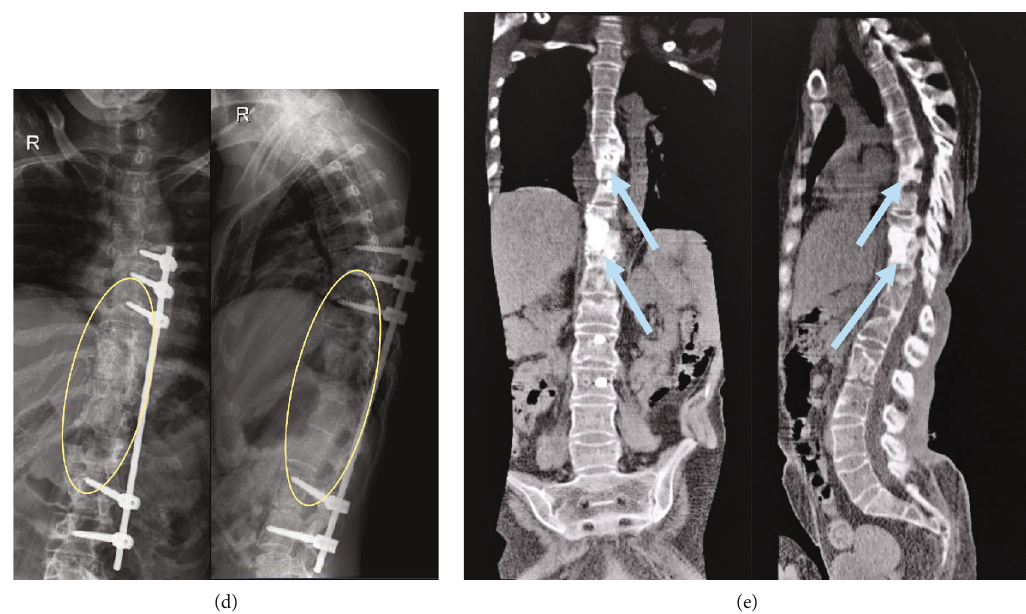
Figure 6: A 30-year-old female (case 3). (a) Preoperative radiography showed defects on multiple corpus vertebrae (T9-12). (b) One-month postoperative radiography showed around 50% of new bone formation along T9-L1, and postoperative radiography also showed instrumentation planted on the left side. (c) Three-month postoperative radiography showed around 65% of new bone formation. (d) Six- month postoperative radiography showed around 85% of new bone formation. (e) Six-month postoperative CT scan showed around 85% of new bone formation. Sites are within yellow circles and pointed using white, black, and blue